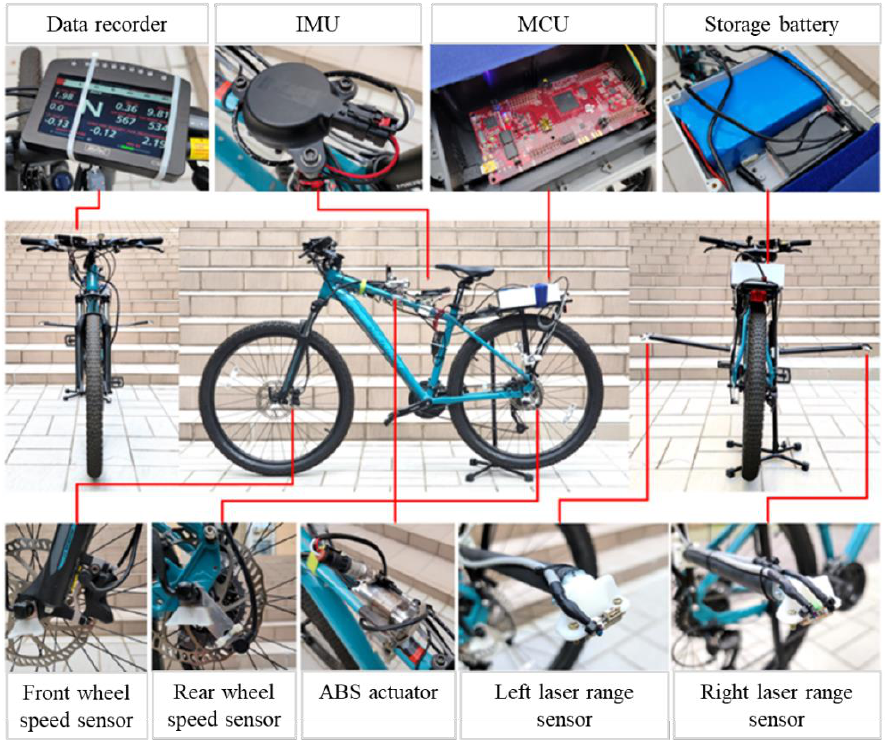
Figure 4. Hardware installed on the experimental vehicle.